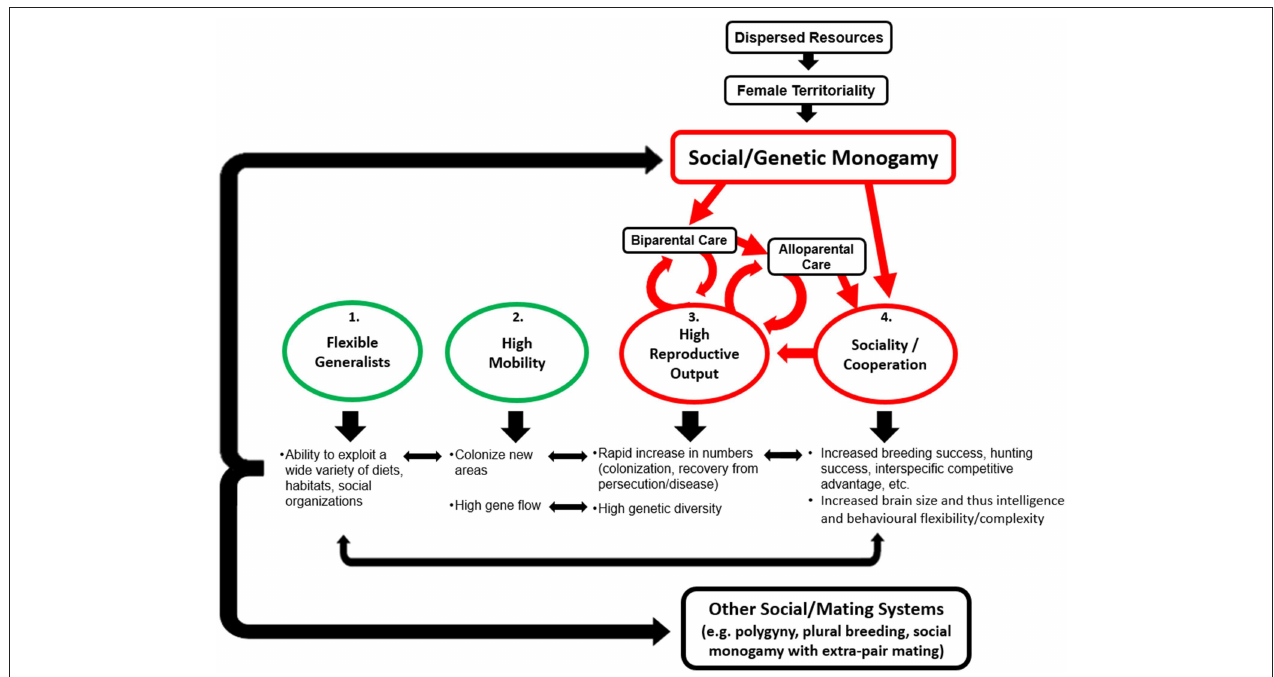
FIGURE 1 | The monogamy as pro-cooperative hypothesis: Canid success may be attributed to four characteristics: (1) their flexible, generalist, adaptable nature, (2) high mobility, (3) high reproductive rates, (4) sociality and cooperation. Traits 1 and 2 appear to be early traits of canids’ phylogenetic history, while 3 and 4 arose from monogamy. Dispersed resources, insufficient to support multiple breeding females but sufficient for a female and male within a territory, seem to have led to the evolution of social monogamy, which in turn led to the evolution of biparental care and, thus, where ecological circumstances allow, alloparental care and sociality/cooperation (trait 4) and high reproductive rates (trait 3). These create feedback loops, where biparental/alloparental care, sociality and cooperation lead to higher reproductive output, which, in turn require biparental/alloparental care, sociality and cooperation. These four canid traits are interconnected and enhance one another. For example, high mobility allows canids to move to new areas, their generalist flexible nature allows them to adapt to these new areas, their ability to quickly increase in number through high reproductive rates allows them to establish in these new areas, with survival and reproduction further enhanced by their sociality and cooperation. The interplay of rapid reproduction and high mobility, allowing gene flow and enhancing genetic diversity, contributes to their adaptability and flexibility, and sociality further contributes to their flexibility through its association with enhanced intelligence, in line with the social brain hypothesis. This flexibility means that canids can adapt social and mating systems to suit local ecological conditions, which may result in social monogamy, or, if ecological conditions are such that superior strategies exist, canids can exploit alternative social/mating strategies yet retain the benefits of high reproductive rates and sociality/cooperation that monogamy afforded (see section Ecological Correlates of Social Monogamy for ecological conditions affecting maintenance of social monogamy vs. alternative strategies, such as polygyny, plural breeding, etc., and section Ecological Correlates of Extra-Pair Mating for ecological conditions affecting genetic monogamy vs. extra-pair mating). It is thus the combination of these four traits, with monogamy at its foundation, that together make up the formula of canid success, explaining the rapid expansion, colonization, and invasion of multiple canid species in recent